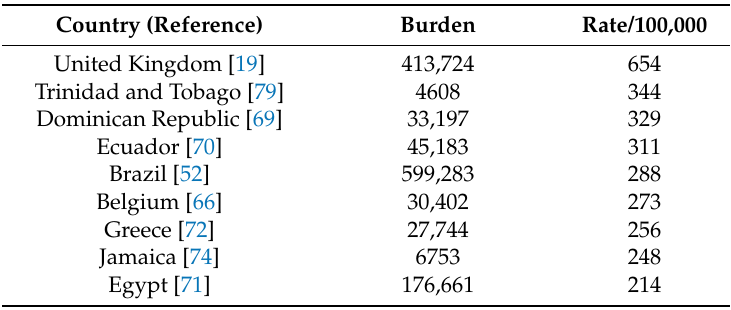
Table 7. Estimated burden of severe asthma with fungal sensitisation.